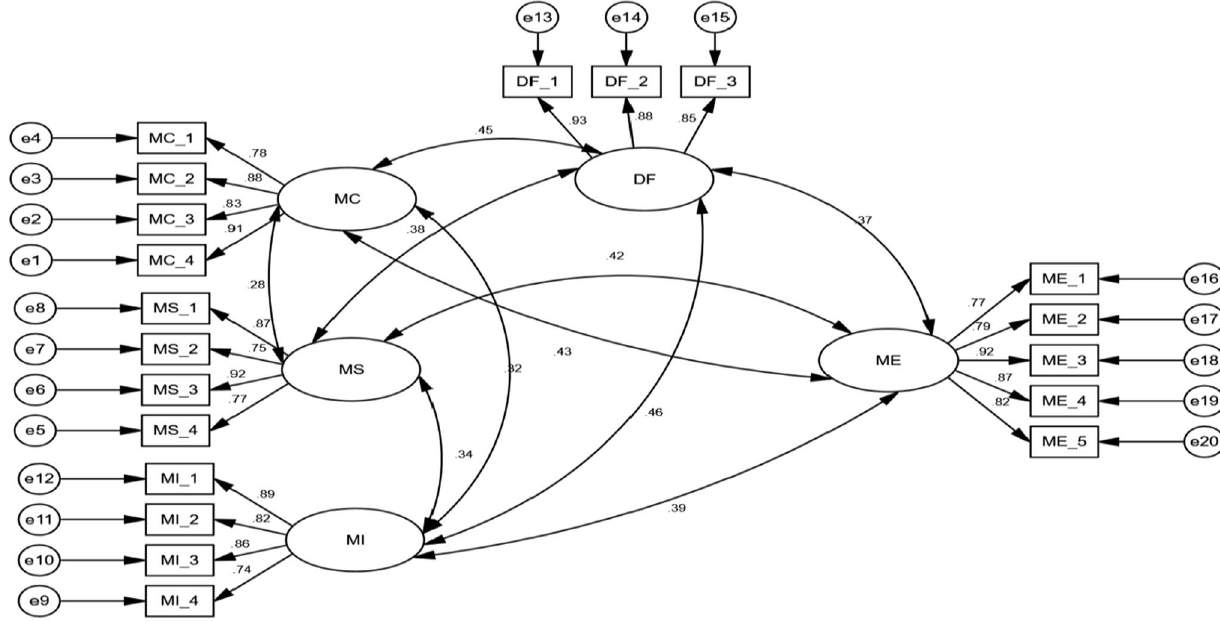
Fig. 2 Measurement